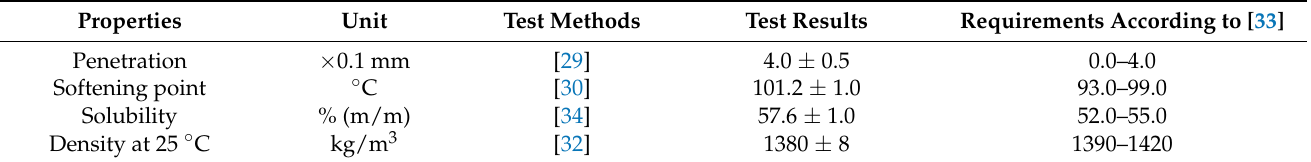
Table 2. Basic properties of